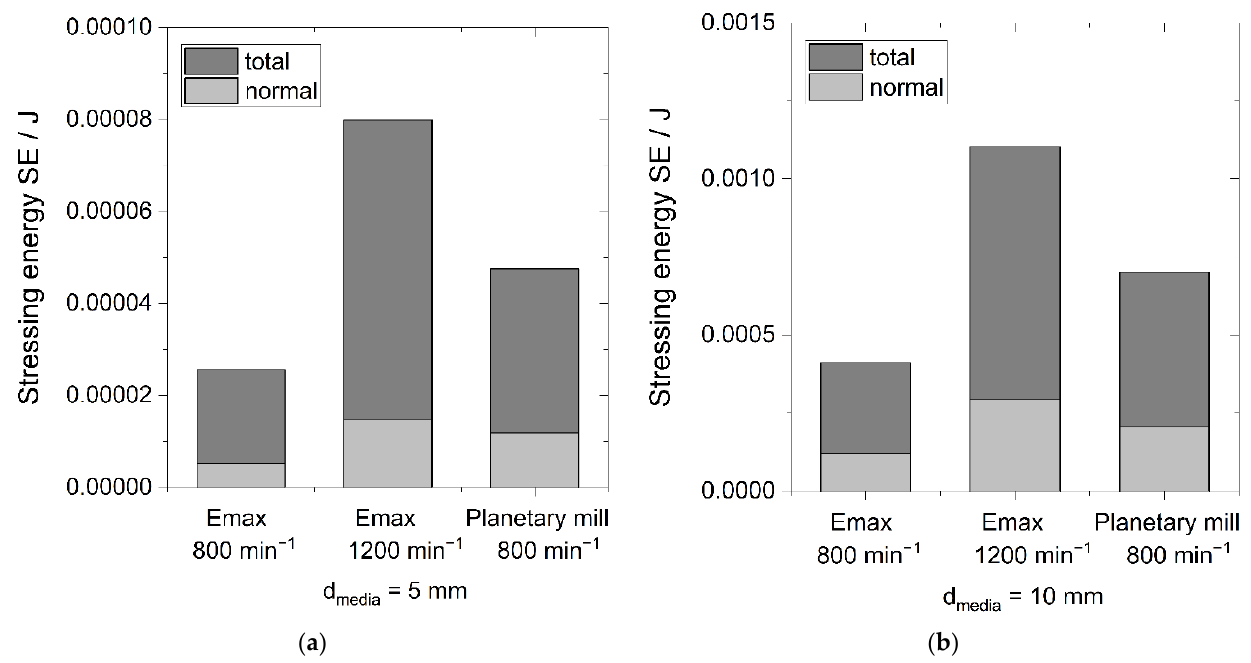
Figure 11. Comparison of total and normal stressing energies for Emax ( n = 800 min − 1 and n = 1200 min − 1 ) and planetary ball mill (n = 800 min − 1 ), ϕ media = 0.3: ( a ) media size 5 mm; ( b ) media size 10 mm.